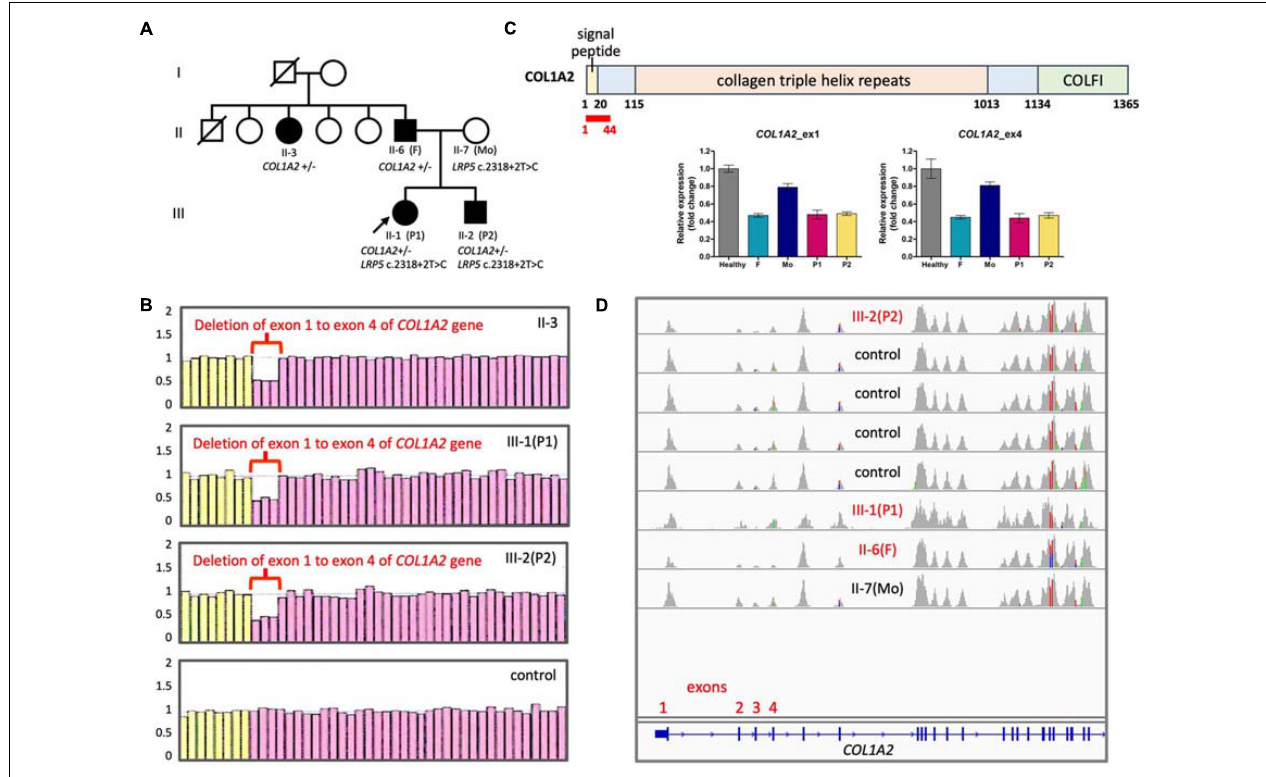
FIGURE 1 | Copy number changes in COL1A2 in the family with OI. (A) Family pedigree. Filled symbols, affected; half filled, heterozygous carrier; unfilled, not clinically affected. (B) Results of MLPA showing fold change of probes detecting COL1A2 . Pink probes are detecting COL1A2 while yellow probes are detecting control genes. (C) (Top panel) Positions of COL1A2 exon 1–4 (encodes amino acid residue 1 ∼ 44 in red) (NP_000080.2). COLFI, Fibrillar collagen C-terminal domain. (Bottom panel) Quantification of copy numbers in COL1A2 exon 1 and exon 4 by qPCR. (D) Integrative Genomics Viewer showing sashimi plots of the results of WES from OI patients and controls. Notice that read coverage of exon 2–4 of COL1A2 are lower than other exons in